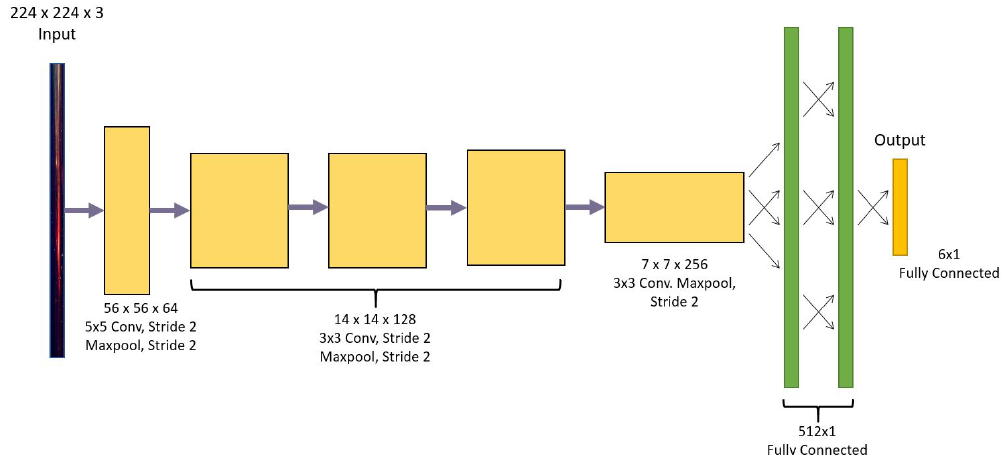
Figure 6. Neural network model proposed by Redmon et al.